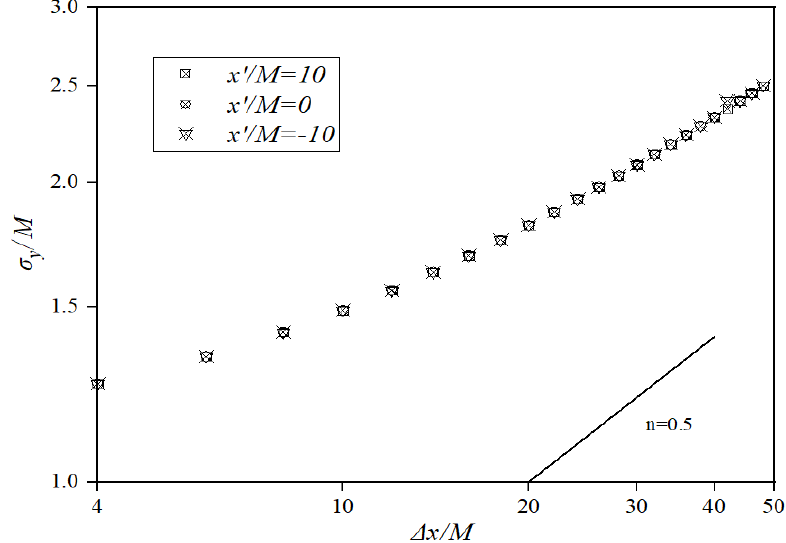
Figure 10. The downstream evolution of the plume spreads at different source locations for S2.